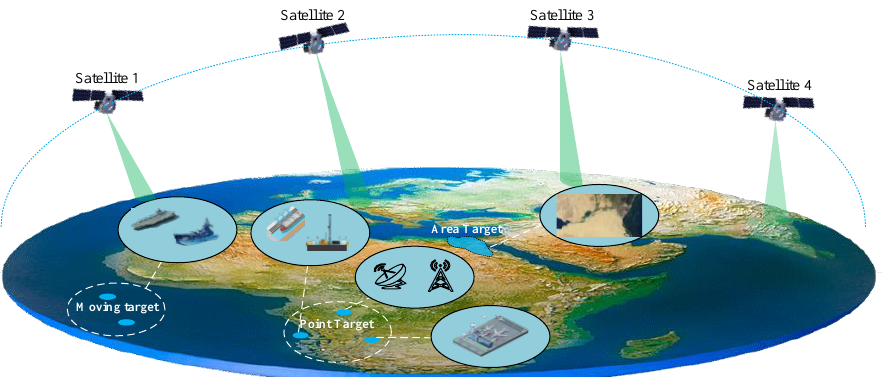
Figure 1. Remote sensing satellite observation mission scene.